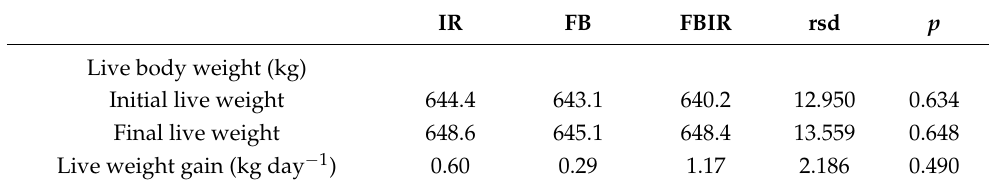
Table 6. Initial and final live weight, live weight gains, and food intakes of dairy cows. Milk yields and composition of raw milk from dairy cows according to the type of total mixed ration (TMR)